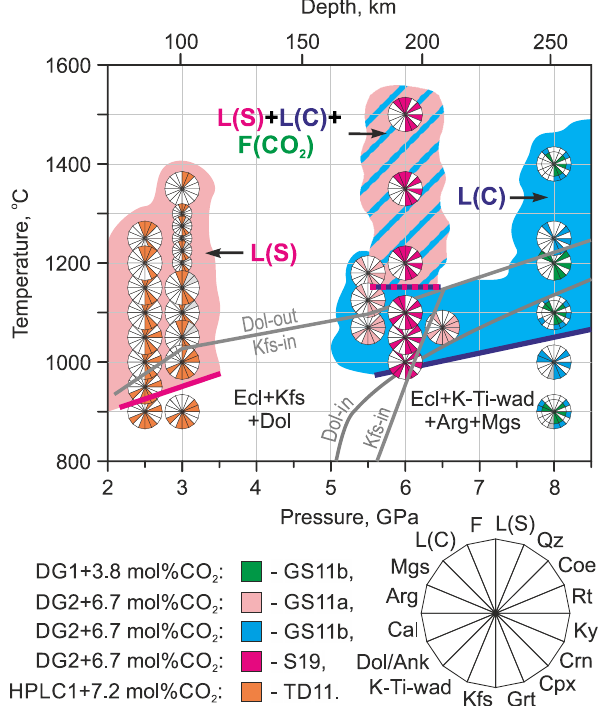
Figure 1. P-T plot illustrating phase relationships in anhydrous carbonated pelite systems. GS11a—[22], GS11b—[21], TD11—[23]. Ecl—eclogitic assemblage: Cpx + Grt + Ky + Coe + Rt. Dol-in—Dol = Arg + Mgs [24]. Kfs-in—2Kfs = Wad + Ky + Coe [25–28]. Dol-out/Kfs-in—The upper-temperature stability limit of Dol+Kfs in pelite under nominally anhydrous conditions. See the Abbreviations section for mineral and phase symbols.